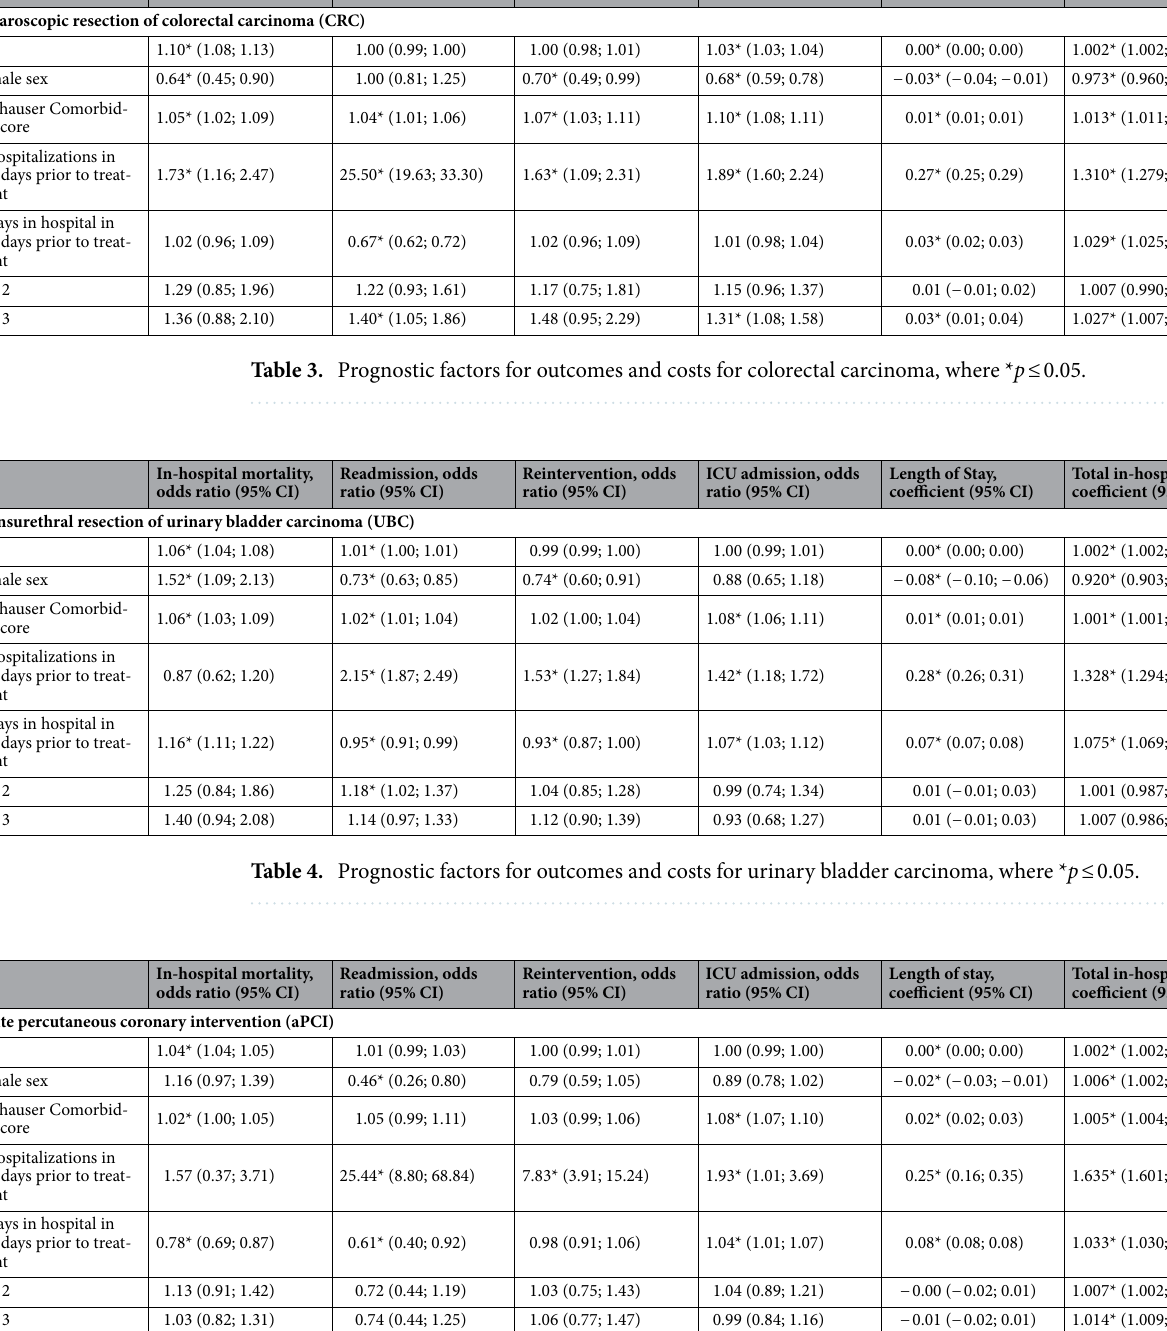
Table 5. Prognostic factors for outcomes and costs for acute coronary intervention, where * p ≤ 0.05.